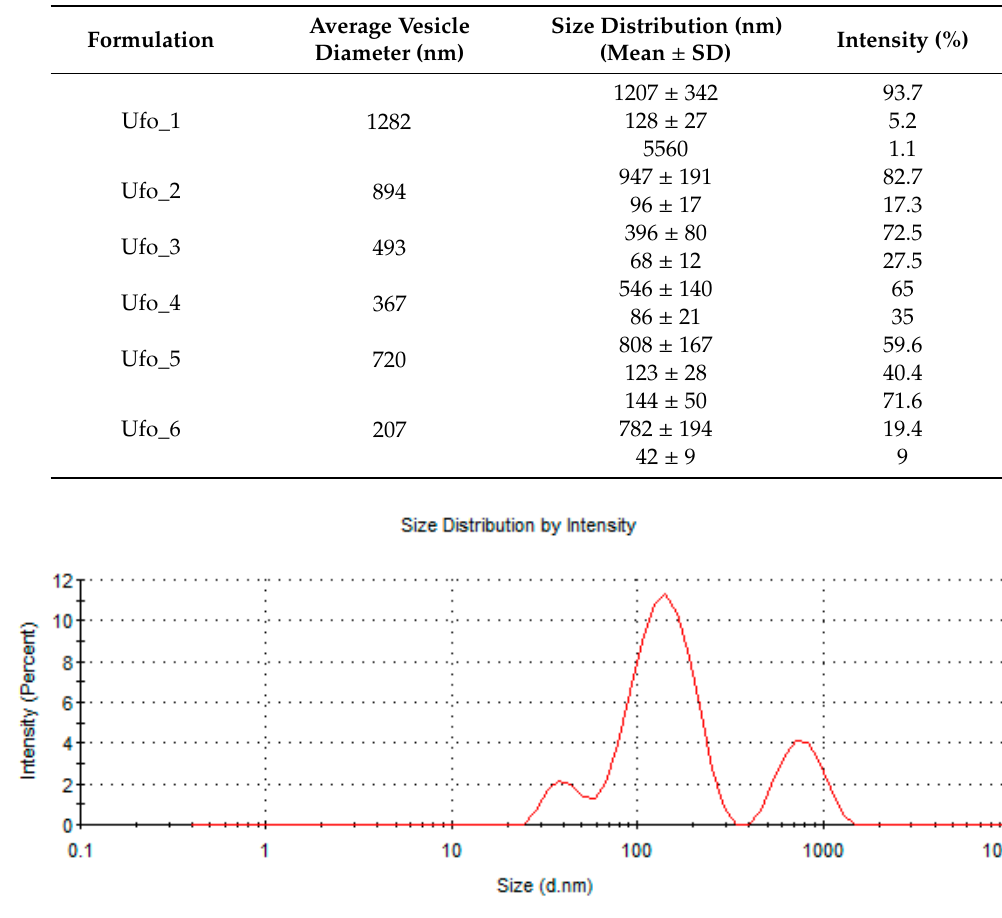
Figure 1. Size distribution curve of Ufo_6.